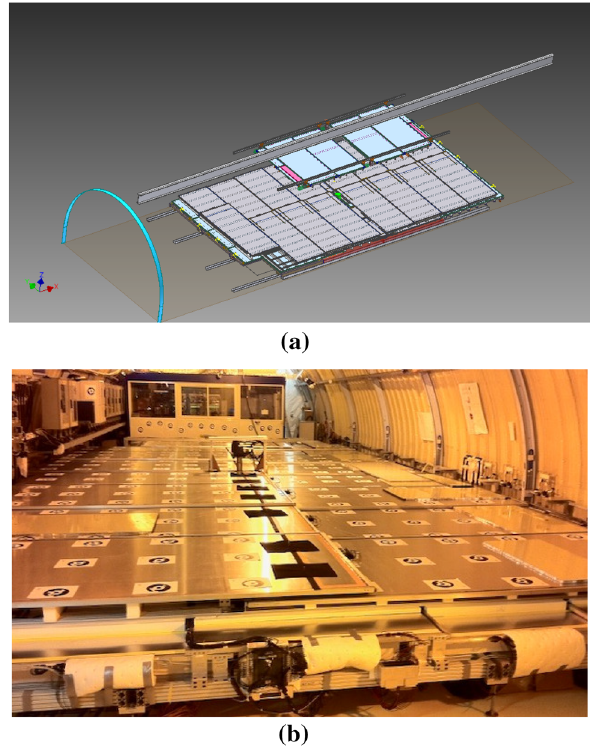
Fig. 5 a Schematic drawing of the OV in the far detector hall. The lower OV rested on the floor of the hall, the upper OV hung in two sections off of the ceiling on crane rails. Each panel was made up of two perpendicular layers, x and y. The chimney, indicated in green, required an opening in the OV coverage area. (The entrance to the hall is in the upper right of the image.) b A photo of the lower OV in the far detector hall is shown